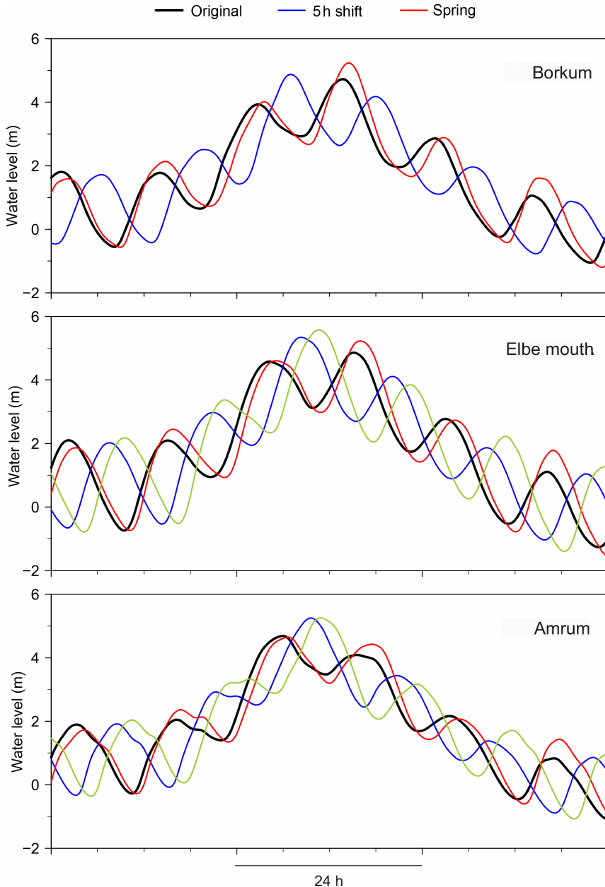
Figure 6. Highest event (EH): time series of the original (black lines) and amplified water levels due to 5-hourly shifting of the tide (blue lines) and due to replacement of the original tide by the high- est spring tide together with shifting of the tide (red lines) for three locations along the German Bight coast. The olive curves show wa- ter levels with the strongest amplification for Elbe mouth and Am-